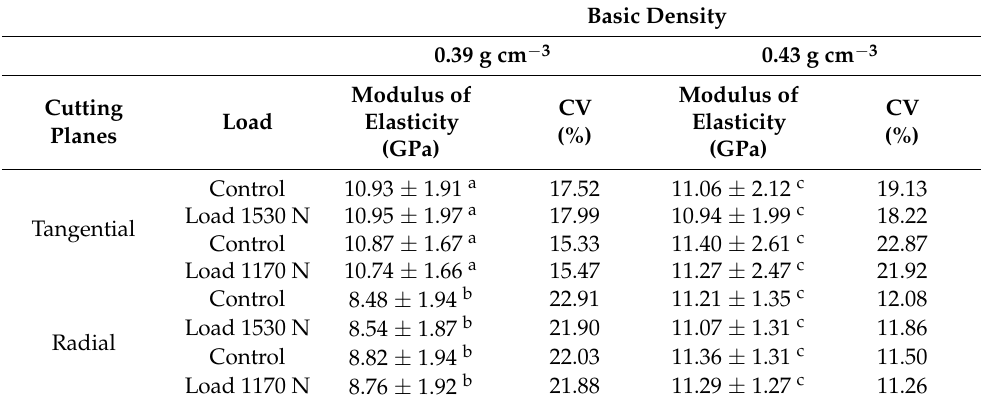
Table 1. Moduli of elasticity of the specimens before (control) and post-tensile